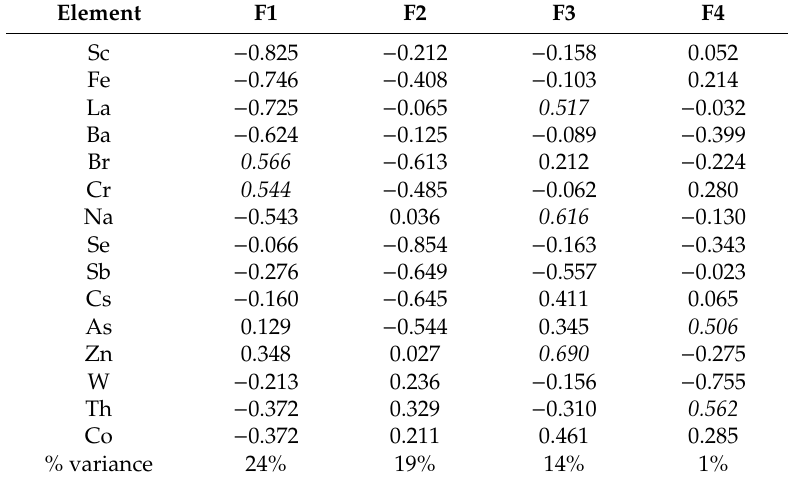
Table 6. Results of principal component analysis (PCA) applied to the PM 10 , PM 2.5 , and PM 1 samples. In italics are presented are the factor loadings greater than 0.5.